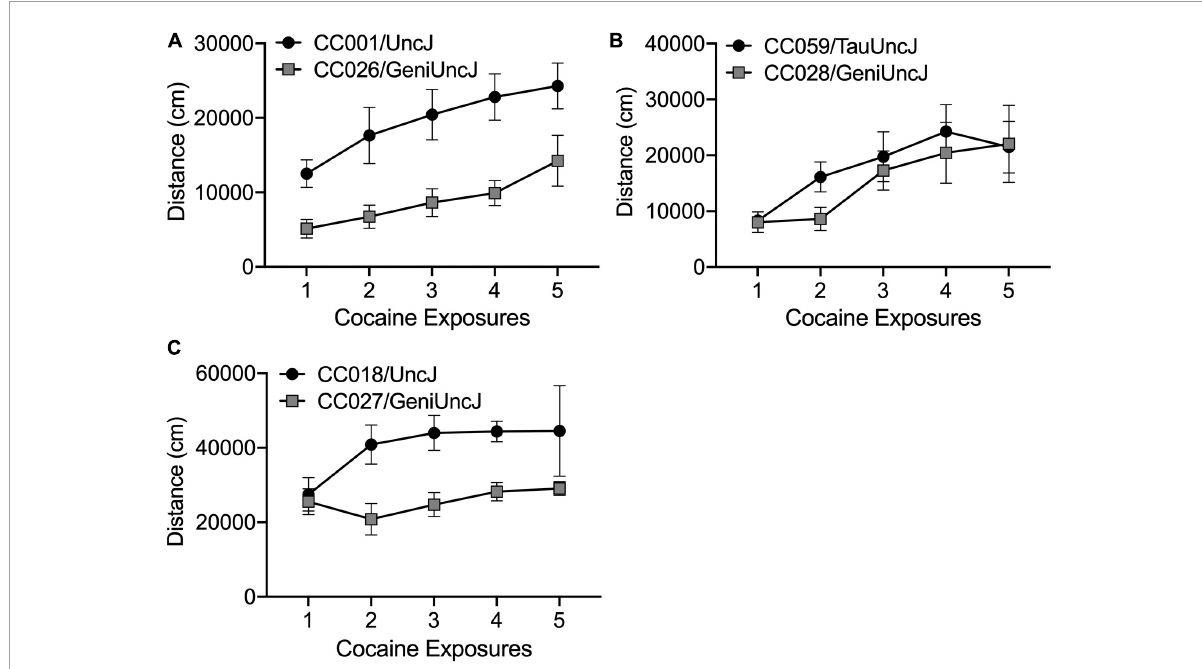
FIGURE7 Different patterns of sensitized cocaine locomotor behavior in CC strains of interest. Cocaine exposures 1–5 correspond to Days 3–11 in the sensitization protocol. (A) CC001/UncJ and CC026/GeniUncJ show similar rates of sensitization but differ in overall locomotor response; (B) CC059/TauUncJ mice exhibit a robust sensitization response across the first four exposures while CC028/GeniUncJ mice don’t begin to show a sensitized response until the third exposure and (C) the maximal locomotor response in CC018/UncJ mice is reached by the second dose whereas CC027/GeniUncJ mice show the highest response after a single exposure and locomotor activity does not increase upon additional